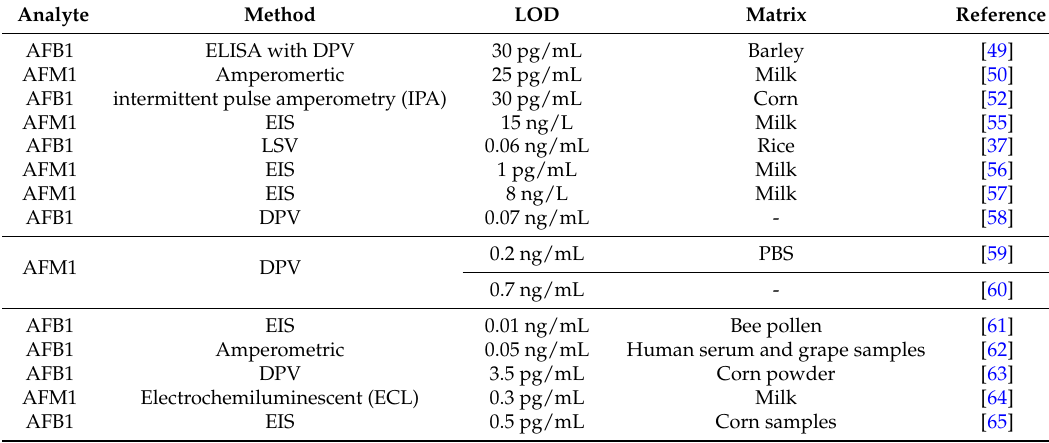
Table 2. Summary of literature reports describing electrochemical immunosensors for aflatoxins detection.